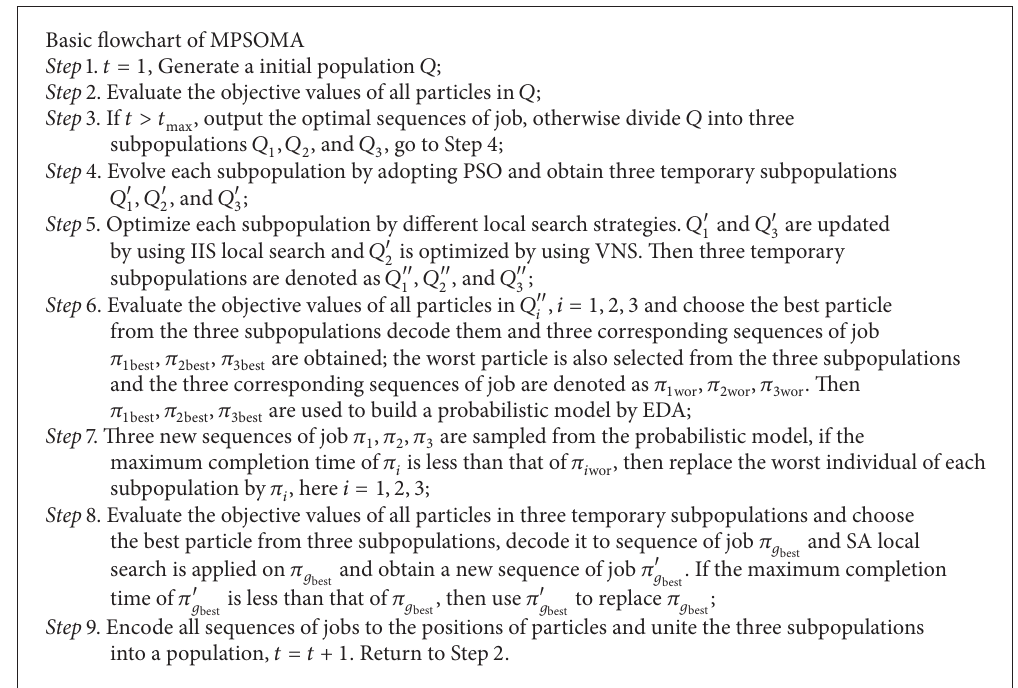
Algorithm 2: The flowchart of